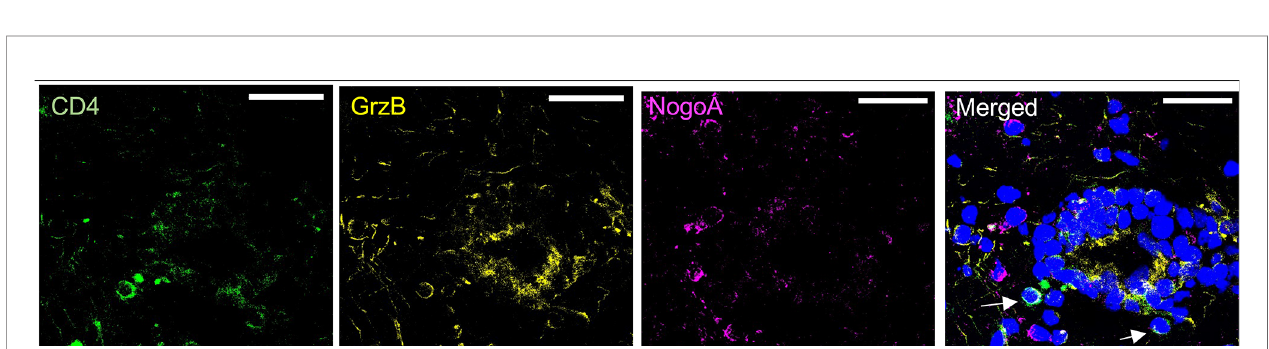
FIGURE 5 | Th17-polarized secretion of granzyme B induces OL death. Percentage of (A) OLs (n = 4 different OL preps) and (B) MO3.13 cell death as measured by FACS (LIVE/DEAD Amcyan staining) after a 16h incubation with activated granzyme B. Each dot represents one independent experiment, n = 4 independent experiments, Friedmann test with Dunn ’ s method. (C) Percentage of MO3.13 cell death as measured by FACS (LIVE/DEAD Amcyan staining) after a 16h incubation with Th17-polarized cells pretreated with granzyme blocker Ac-IEPD-CHO (Ac) or DMSO control; each dot represents one donor, n = 5 – 6 T cell donors, diamond = mean, Wilcoxon test (35 m g/ml), and paired t-test (50 m g/ml). *p < 0.05; **p < 0.01.